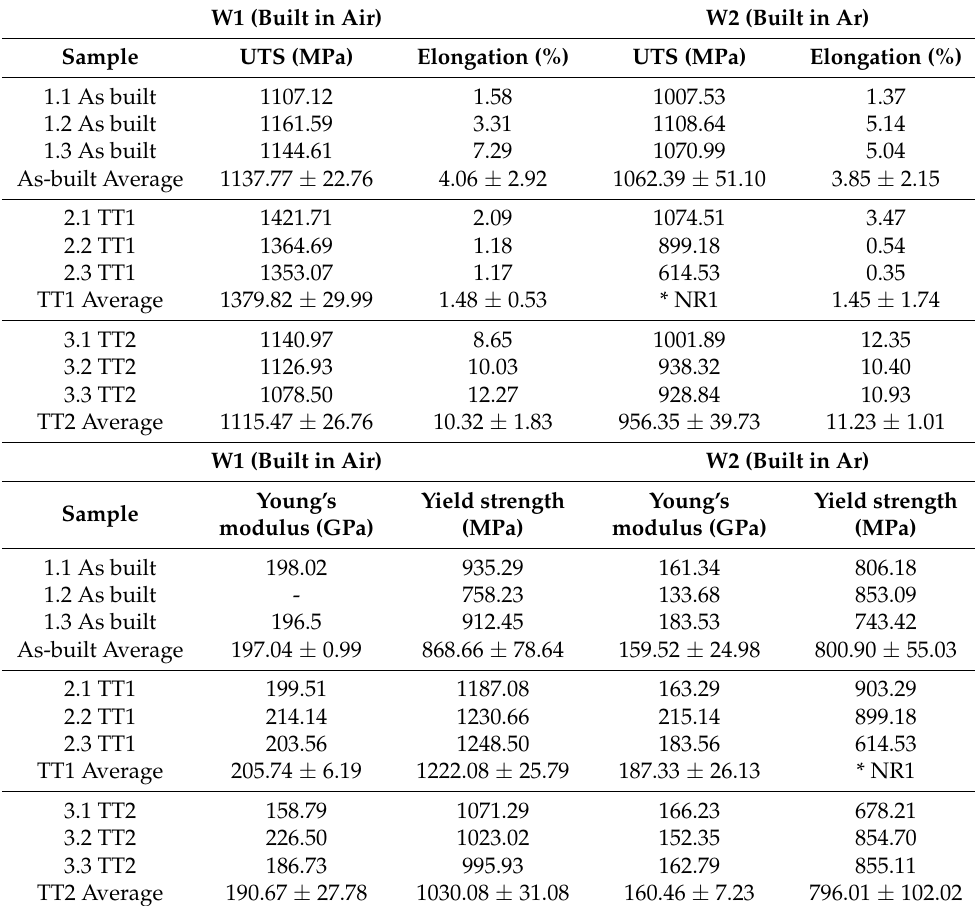
Table 2. Mechanical property values of the tested